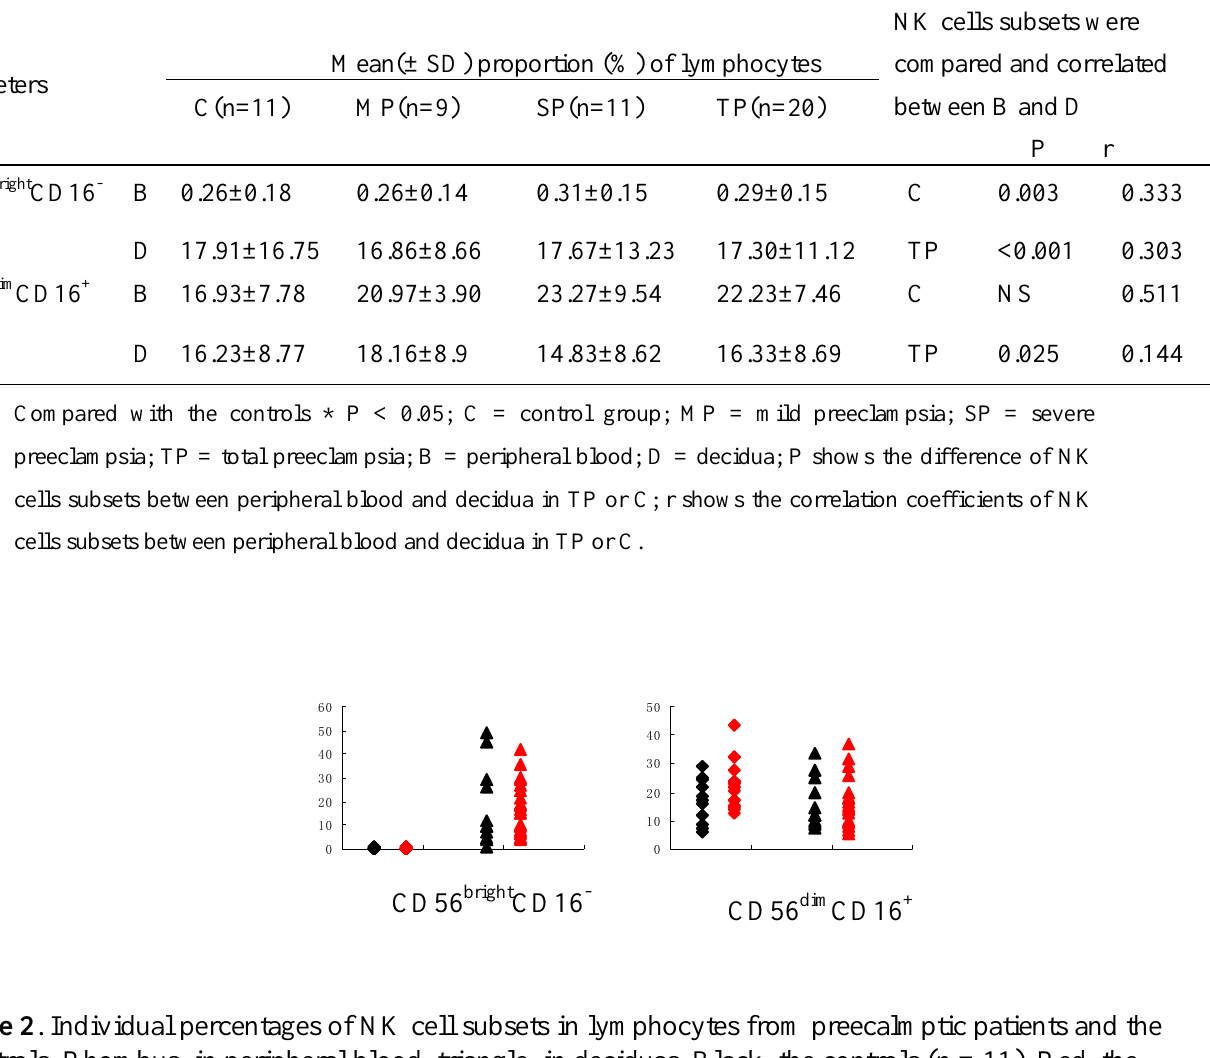
Table 2 . Percentages of NK cells and uNK cells subsets in lymphocytes from preecalmpsia patients and control.